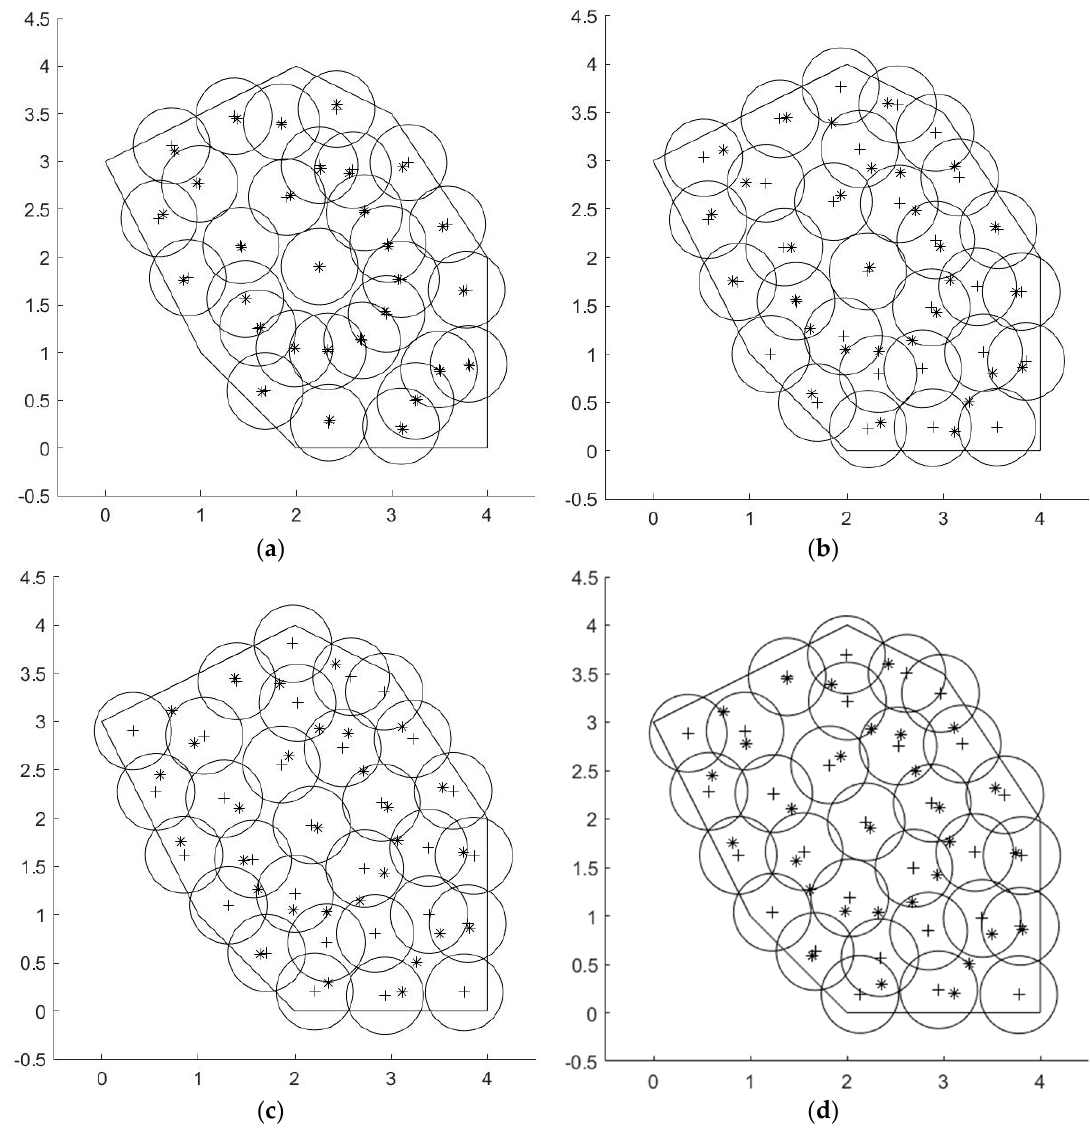
Figure 11. The optimal deployment scheme obtained by the proposed deployment algorithm, where method 2 (Test 3) was used to initialize the positions of the UAVs: ( a ) represents the position of the UAVs in iteration #1; (b ) represents the position of the UAVs at iteration #17; ( c ) represents the position of the UAVs at iteration #34; and ( d ) represents the position of the UAVs at iteration #50.